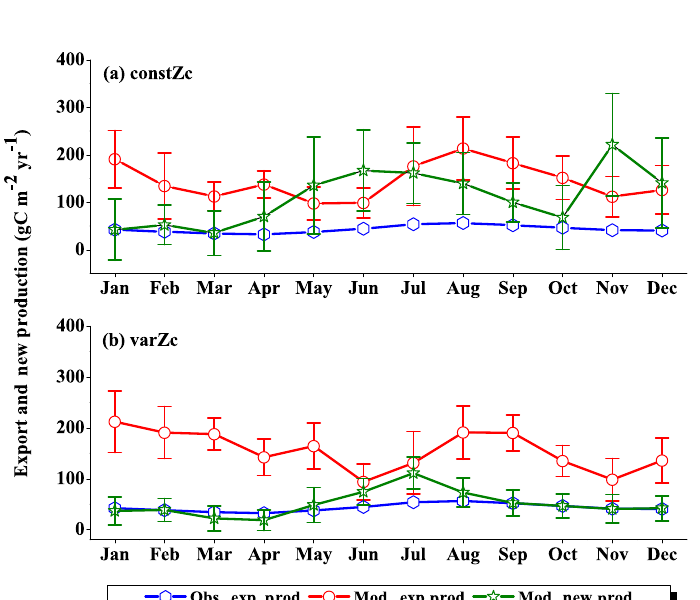
Figure 11. Same as Fig. (7), but for